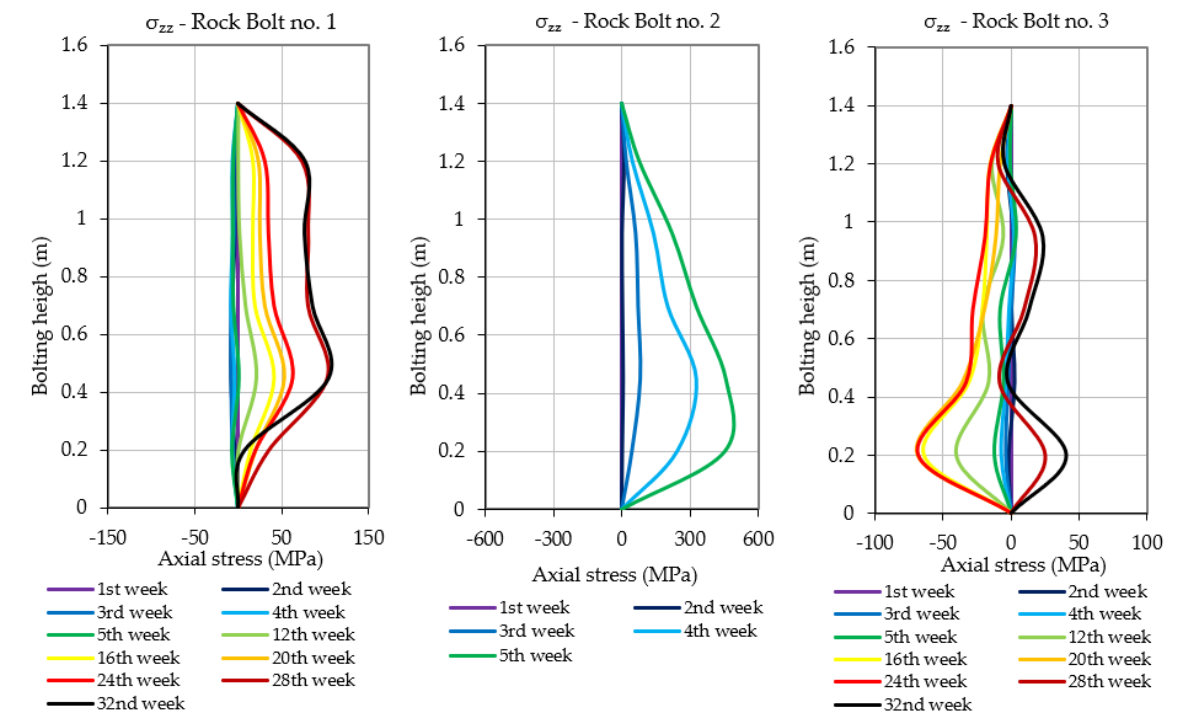
Figure 13. Axial stresses measured along rock bolts ’ bars during the underground measurement.